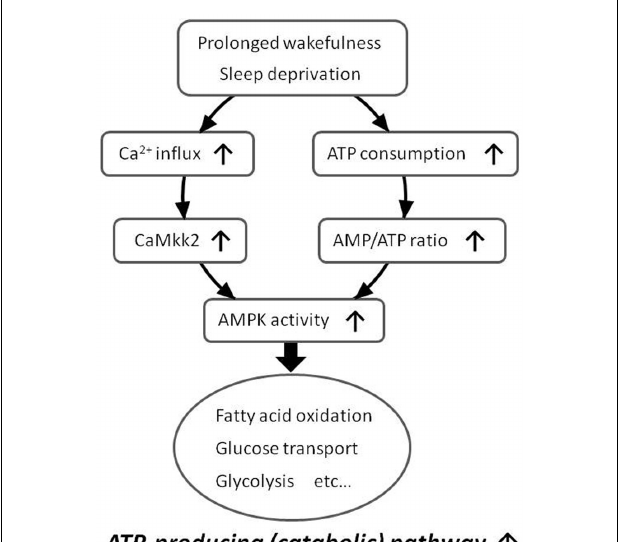
FIGURE 2 | Schematic of gliotransmission via astrocytic processes. Glutamate released from presynaptic neurons binds to postsynaptic AMPA receptors (AMPAR) and also to metabotropic glutamate receptors on astrocytes.This stimulates an increase in intracellular Ca 2 + concentration in astrocytes, which in turn release ATP. Accumulation of adenosine from ATP breakdown in the extracellular space acts via adenosine 1 receptors (A1Rs) to depress synaptic activity.